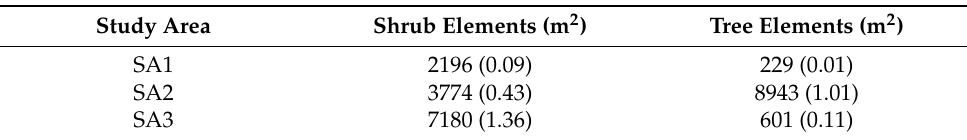
Table 1. Aggregated surface area of the reference elements in m 2 and as percentage of the study area (between brackets) inventoried in SA1, SA2 and